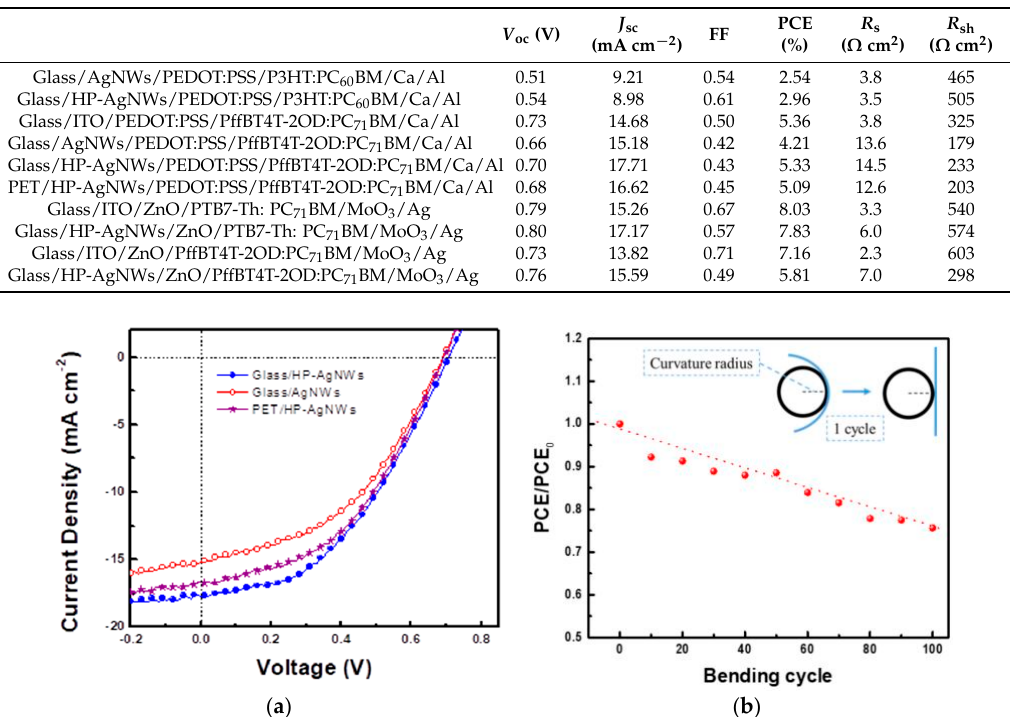
Table 1. J - V characteristics of PSCs based on AgNW electrodes and three different types of active layer. PCE, power conversion efficiency.